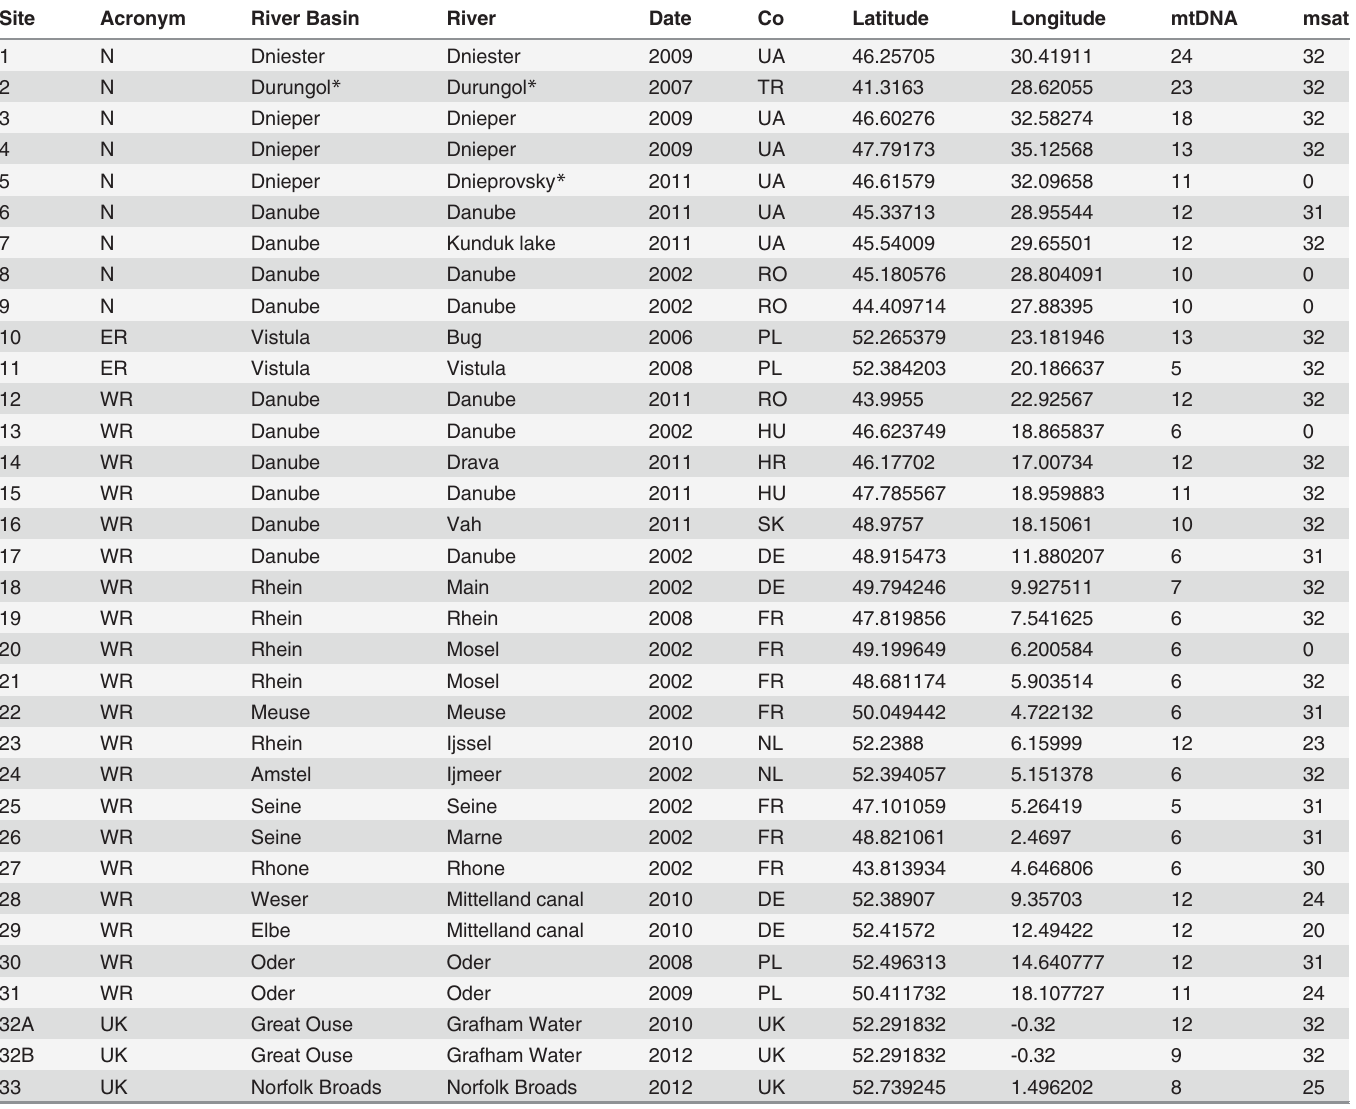
Table 1. Sampling sites of Dikerogammarus villosus